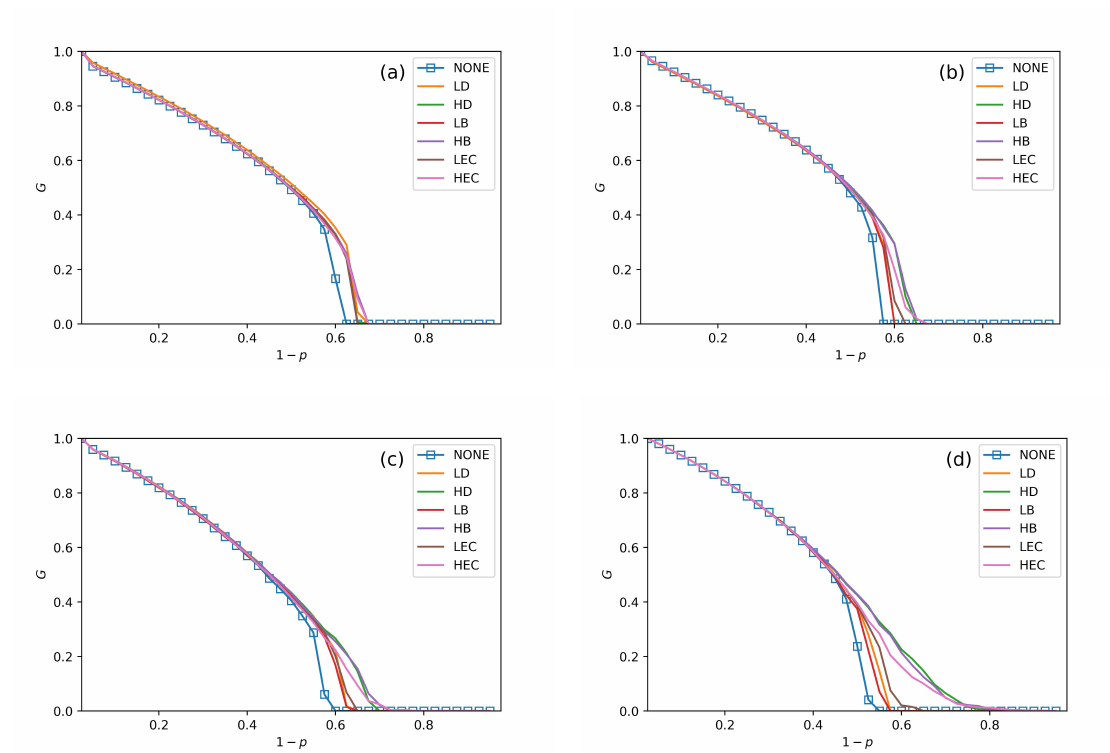
Figure 5. The fraction of function nodes in systems when f N = 30% in ER–ER, ER–SF, SF–ER, and SF–SF systems, which is shown in ( a – d ),